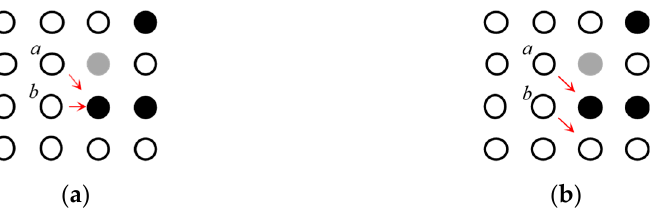
Figure 5. Comparison of local gradient calculation results. The red arrow represents the direction in which the pixel intensity value changes the most, which can also be called the gradient value. ( a ) the gradient of pixel a and pixel b in the original image; ( b ) the gradient calculation result of the CGI method.